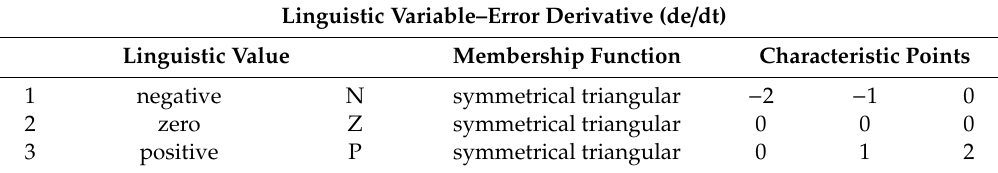
Table 2. The first version of the controller–error derivative.